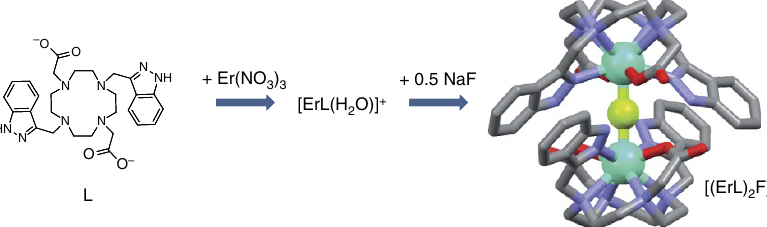
Figure 1 | Formation of the supramolecular erbium dimer. The ligand L react with Er 3 þ salts in water to form an [ErL(H 2 O)] þ complex. In the presence of half an equivalent of fluoride anions two complexes form an association in which the F (cid:2) anion is sandwiched between the two complexes leading to the [(ErL) 2 F] þ dimer. The association is strengthened by two intercomplex stacking interactions and four hydrogen